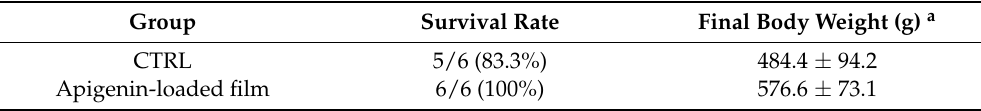
Table 3. The survival rate and final body weight of rats after treatment. a Data are given as the mean ± SD ( n = 6).